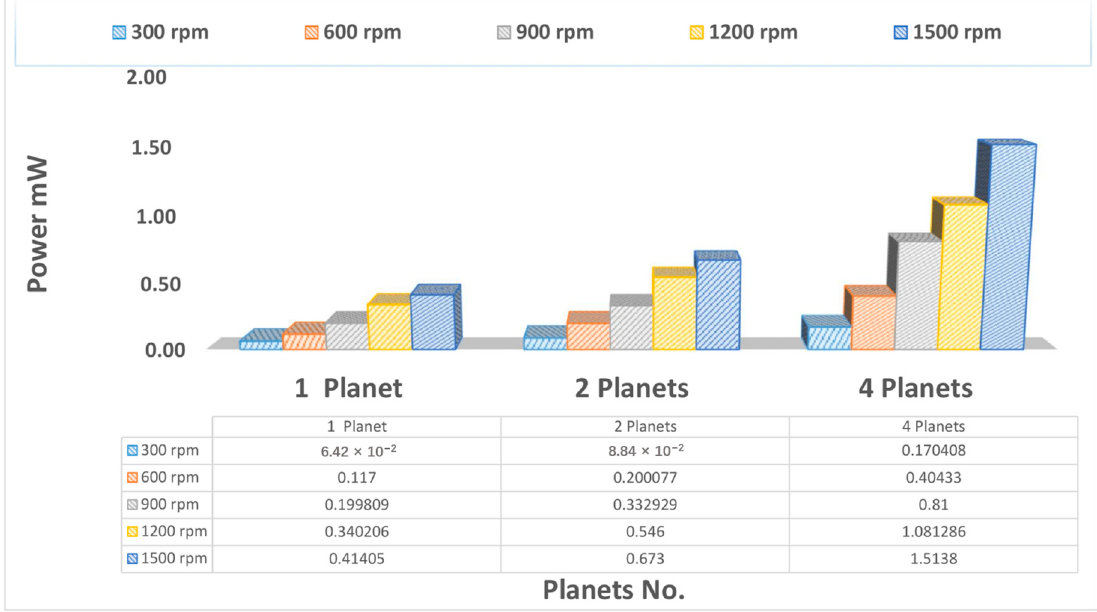
Figure 13. Increasing the level of output power with increasing speed.